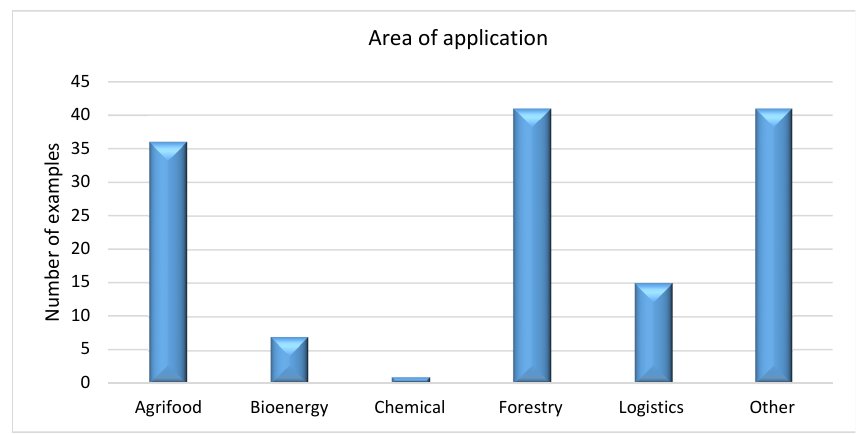
Figure 4. Number of identified technologies, tools, and services in different application sectors.